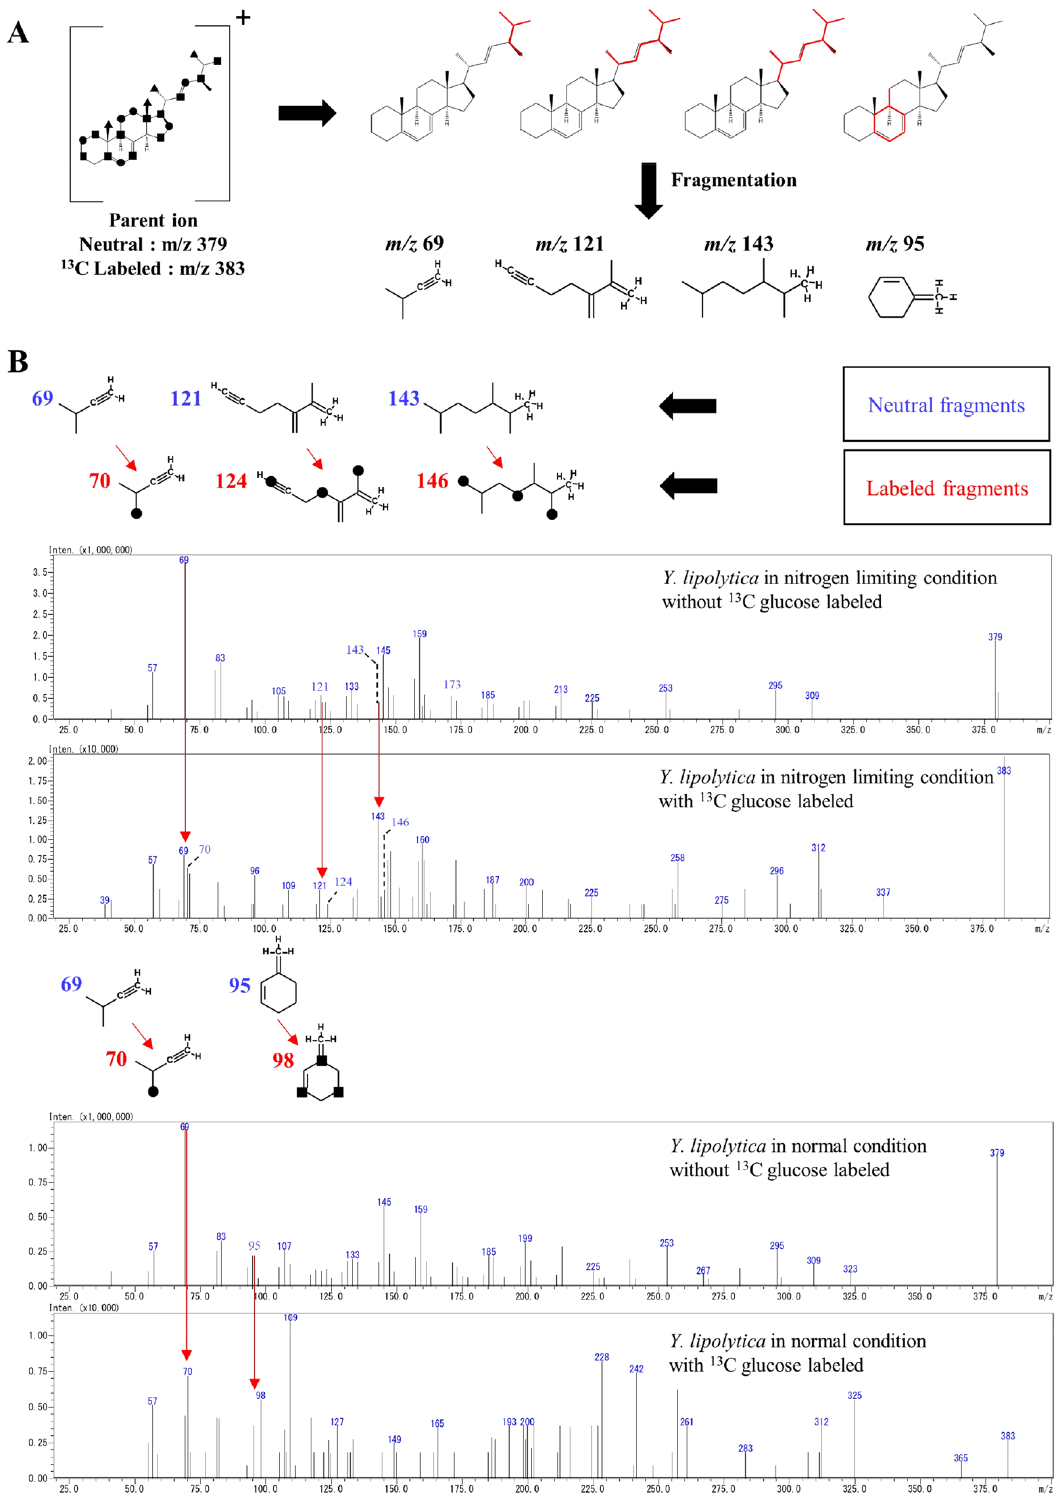
Figure 3. Mass spectroscopic analysis of 13 C labeled ergosterol. ( A ) the predicted fragment from parent ion; ( B ) the mass spectra comparing the neutral and the labeled ergosterol product ion. The assign fragment structure elucidates the m/z increased specifically to the MVA pathway or the MEP pathway; circles indicate the theoretically labeled position from the MEP pathway, squares indicate the theoretically labeled position from the MVA pathway. All fragment structure assignment was done using CFMID 3.0 software. The predicted m/z and the structure of fragments resulted from the MEP pathway and the MVA pathway are found in Supplementary Fig.